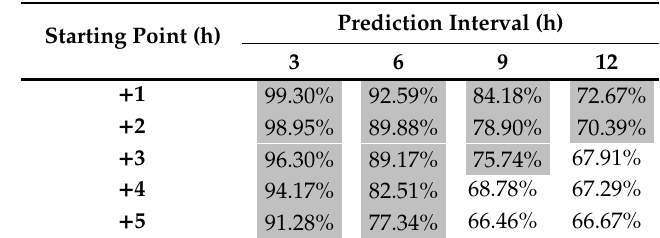
Table 6. Forecast accuracy percentages rate for the flood event in 2013. This table shows the grid percentage to the total wet grids with average RMSE within 0.3 m. The forecast begins by the starting point, several hours later than the event beginning for the real-time forecast.